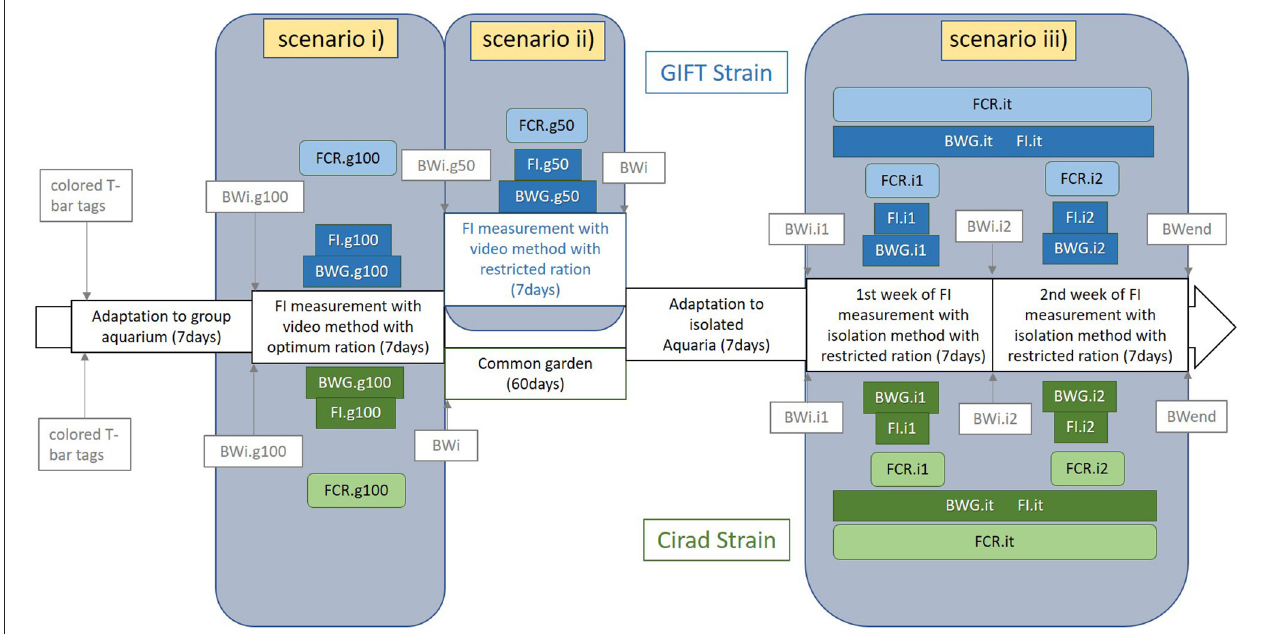
FIGURE 1 | Scheme of the different scenarios designed in the experimental protocol and corresponding traits measured in each period for the GIFT strain (on the top of the figure and in blue) and the Cirad strain (on the bottom of the figure and in green). The three different scenarios were: (i) in groups fed an optimal ration (g100) or (ii) fed a 50% restricted ration (g50) both with video records of all meals and (iii) reared in isolation and fed a 50% restrictive ration. BWi, individual body weight; BWend, individual body weight at the end of the experiment; BWG, body weight gain; FI, feed intake; FCR, feed conversion ratio; .g100, fish reared in groups with 100% DFR ration; .g50, fish reared in groups with 50% DFR ration; .i1, .i2, and .it, fish reared in isolated aquaria during the first, the second, and the total of the first and second weeks of isolation period. The main measured traits were highlighted and the background of the frame was colored.